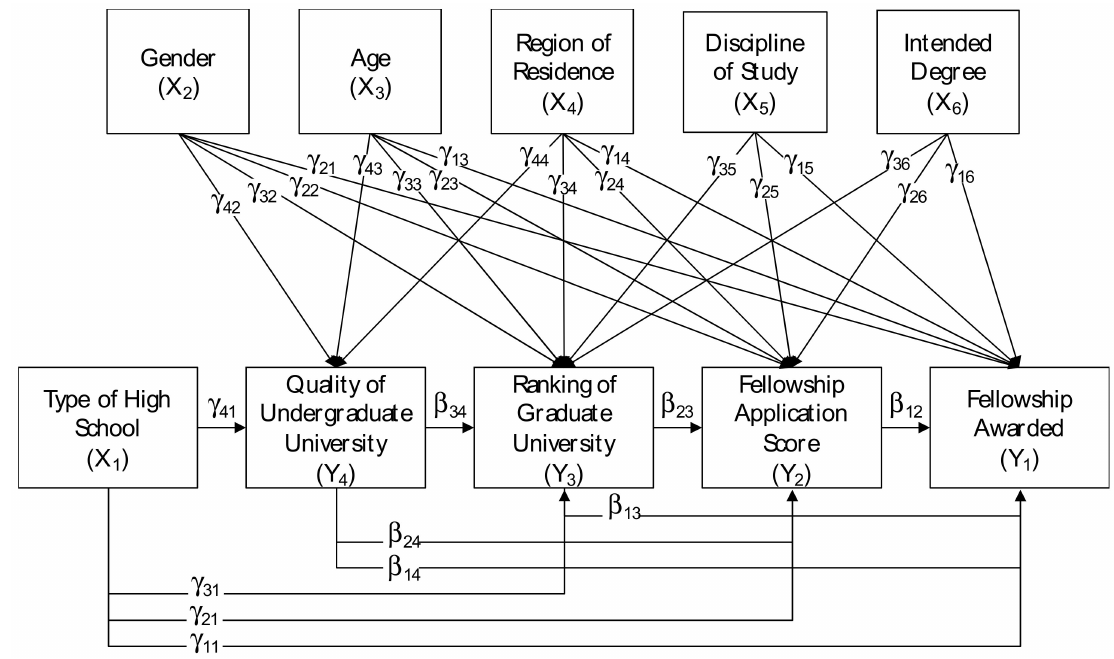
Figure 1. Path diagram of hypothesized relationships among variables in the